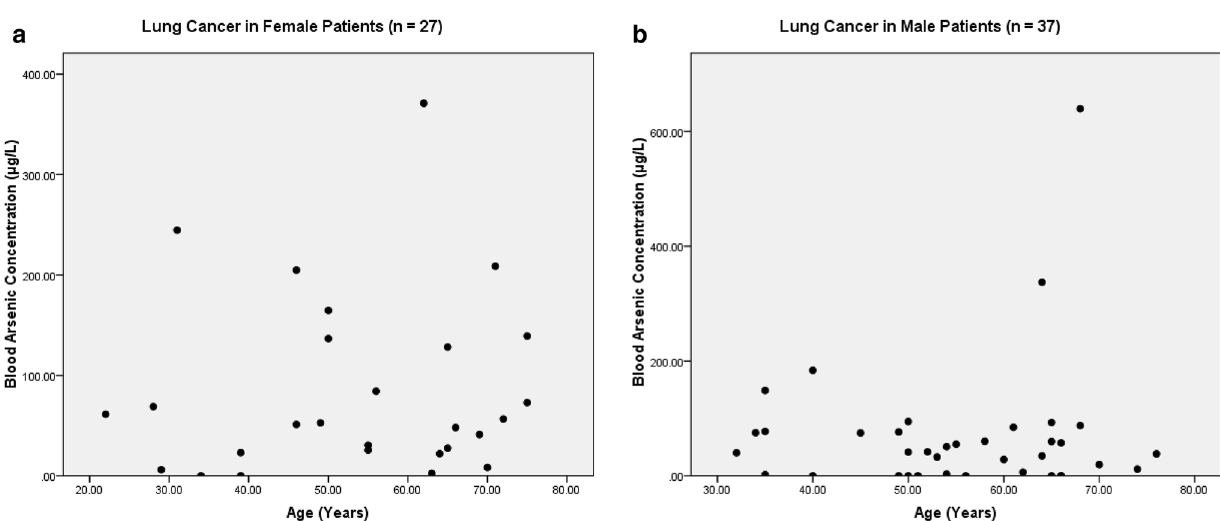
Figure 13. The correlation coefficient between blood arsenic levels and age of the female vs male lung cancer patients (P <